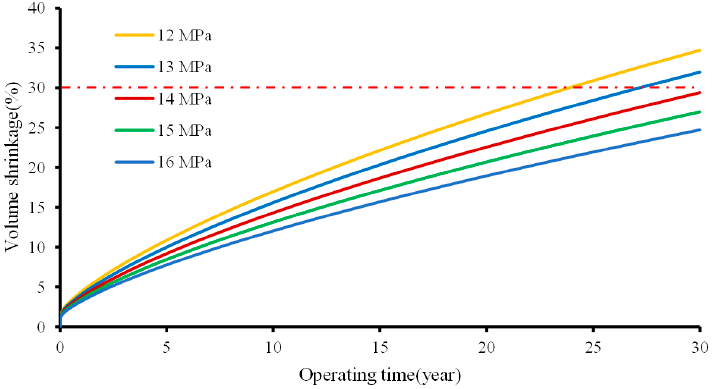
Figure 7. Volume shrinkage rate versus operating time under different minimum internal gas pressures.